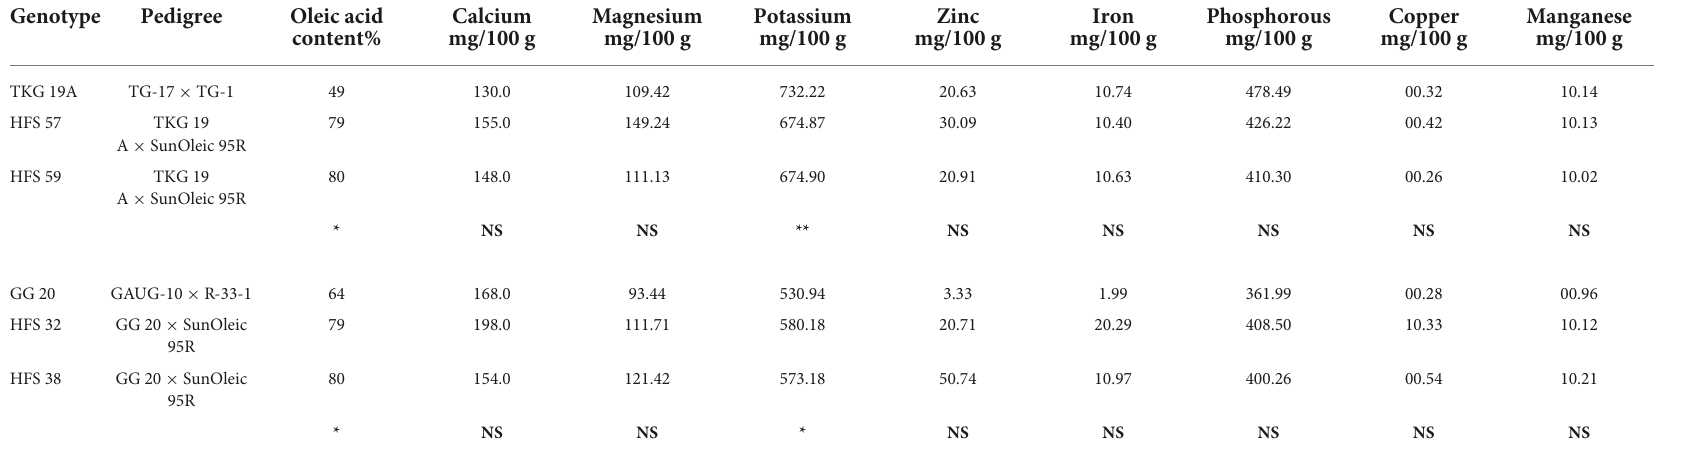
TABLE 9 Mineral compositions in the seeds of normal oleic groundnut varieties and their high oleic content breeding lines. Genotype